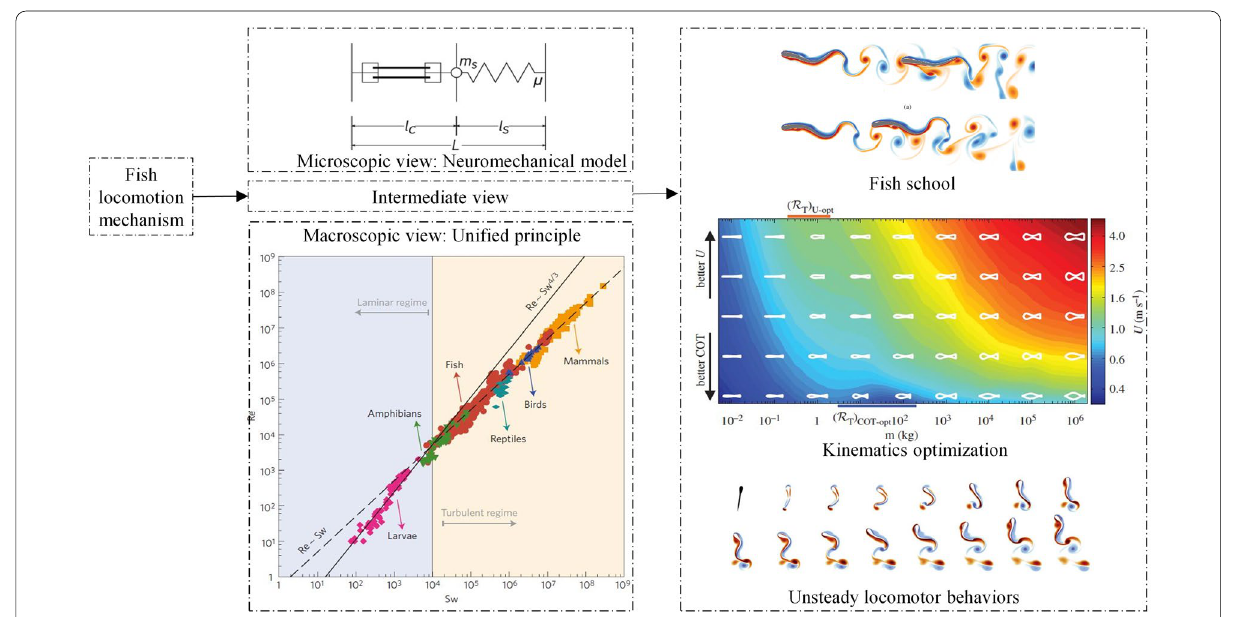
Figure 3 Fish locomotion mechanism research (The figures of macroscopic view and microscopic view are produced from Refs. [81] and [82], respectively. The figures of intermediate view (up to down) are reproduced from Refs. [83, 84] and [85],